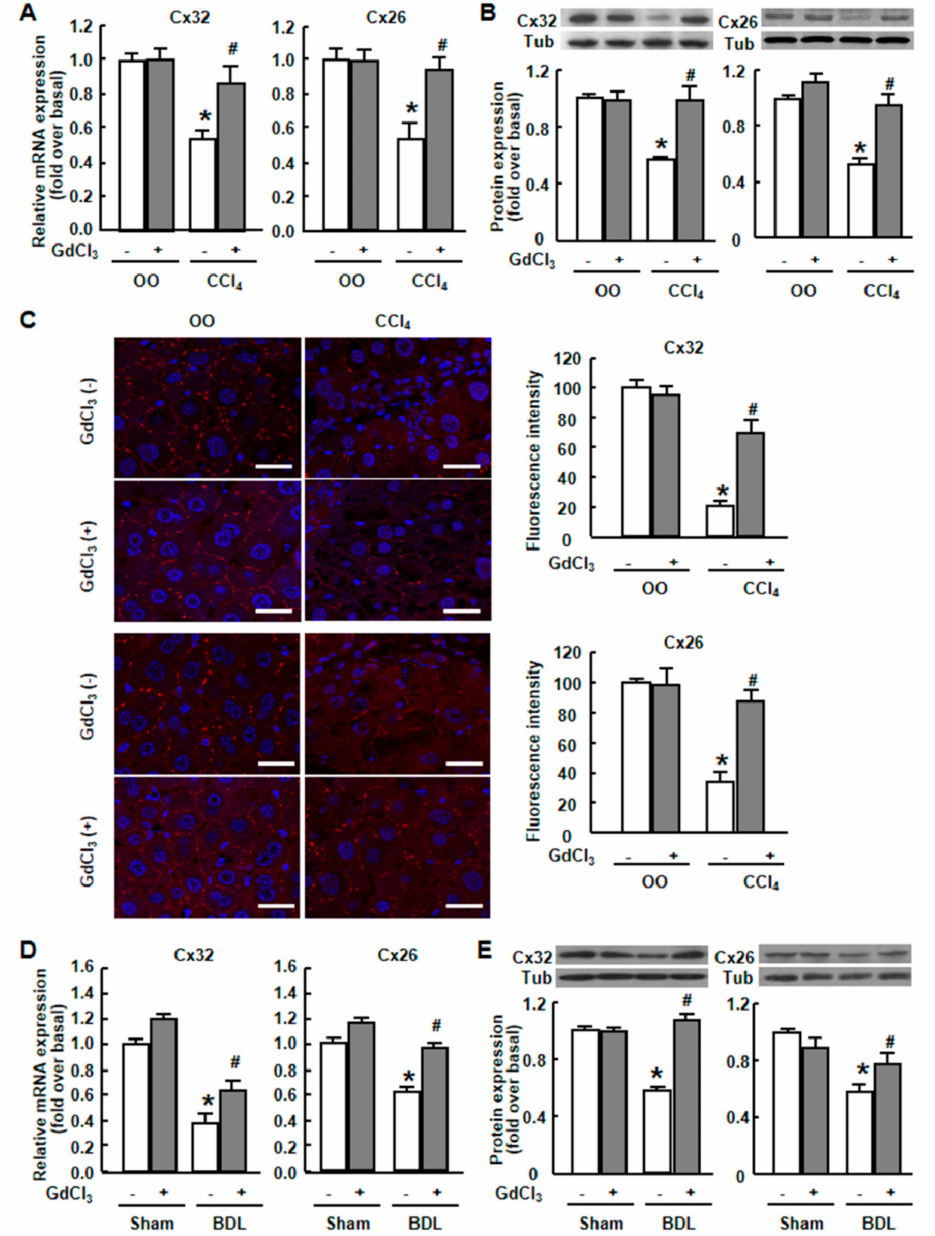
Figure 2. Cx32 and Cx26 expression in injured liver tissue with or without gadolinium chloride (GdCl 3 ) administration. Four weeks after GdCl 3 administration in CCl 4 -treated mice or two weeks after GdCl 3 administration in bile duct ligation (BDL) mice, liver tissue was collected. Immuno-fluorescence staining, western blot and qRT-PCR analysis for the expression of Cx32 and Cx26 were performed. ( A ) Cx32 and Cx26 mRNA expression in CCl 4 -injured liver. ( B ) Cx32 and Cx26 protein expression in CCl 4 -injured liver. ( C ) Immunofluorescence staining for Cx32 and Cx26 in OO-treated, CCl 4 -treated, GdCl 3 plus OO-treated and GdCl 3 plus CCl 4 -treated liver. Scale bars, 20 µ m. ( D ) Cx32 and Cx26 mRNA expression in BDL-injured liver. ( E ) Cx32 and Cx26 protein expression in BDL-injured liver. Typical autoradiograms are shown. Expression of tubulin was checked to correct for variations in protein loading and transfer. All results were confirmed in three independent experiments. Data are presented as the mean ± SEM, and were analyzed by ANOVA for analysis of variance. * p < 0.05 vs . OO-treated mice. # p < 0.05 vs . CCl 4 -treated mice without GdCl 3